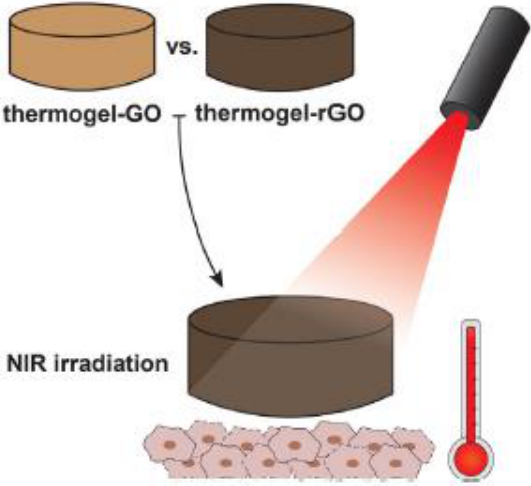
Figure 21. Schematic representation of photothermal therapy (PTT) mediated by thermogel–GO and thermogel–rGO. Reprinted with permission. Copyright 2020, Elsevier [92].